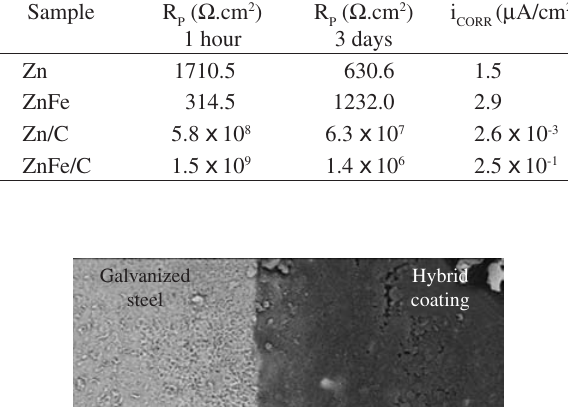
Table 2. Values of R Sample